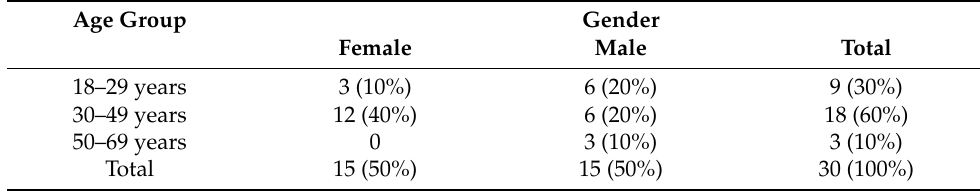
Table 2. Characteristics of the survey respondents ( n = 30).